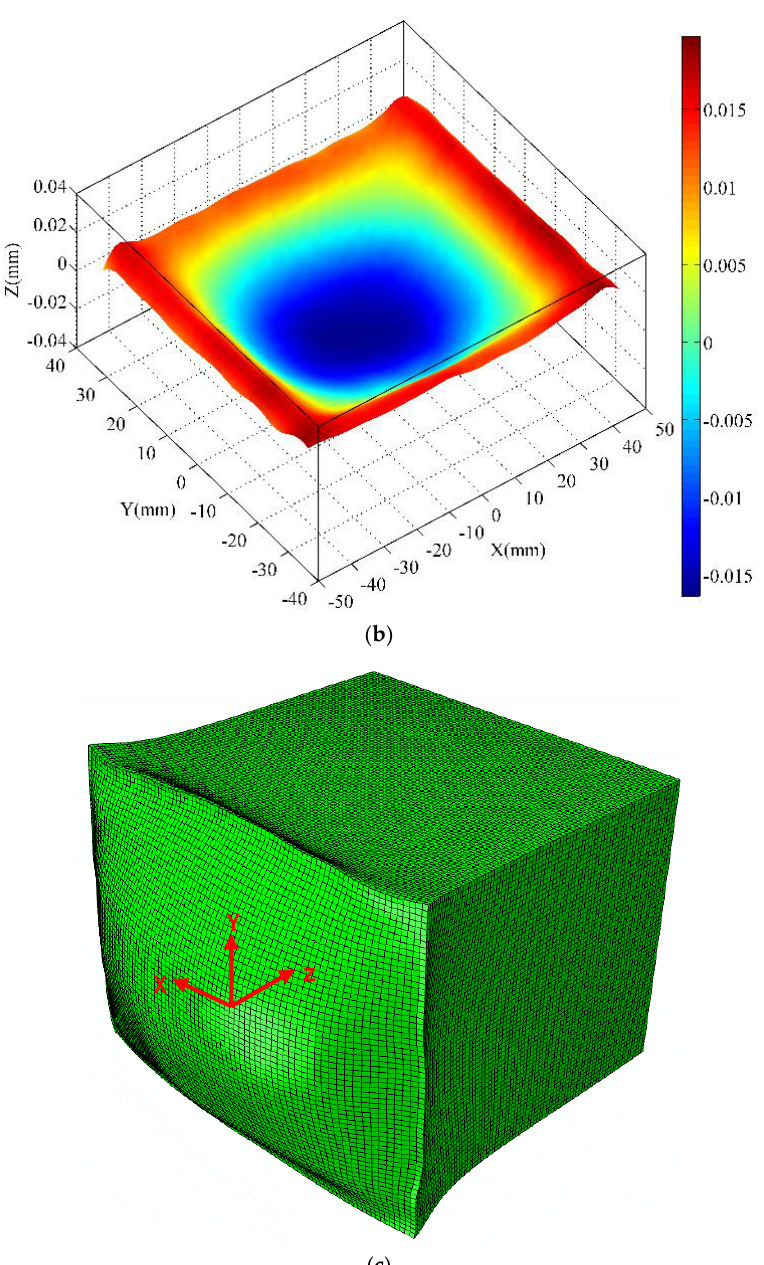
Figure 6. An example of coordinate measuring machine (CMM)-measured data-processing stages: ( a ) CMM-measured raw data for the cut plane 1 in the as-quenched specimen; ( b ) the smoothed surface for the cut plane 1 in the as-quenched specimen; ( c ) the 3D FEM model that applies the smoothed surface contour as the displacement boundary, with displacements magnified by a factor of 500.